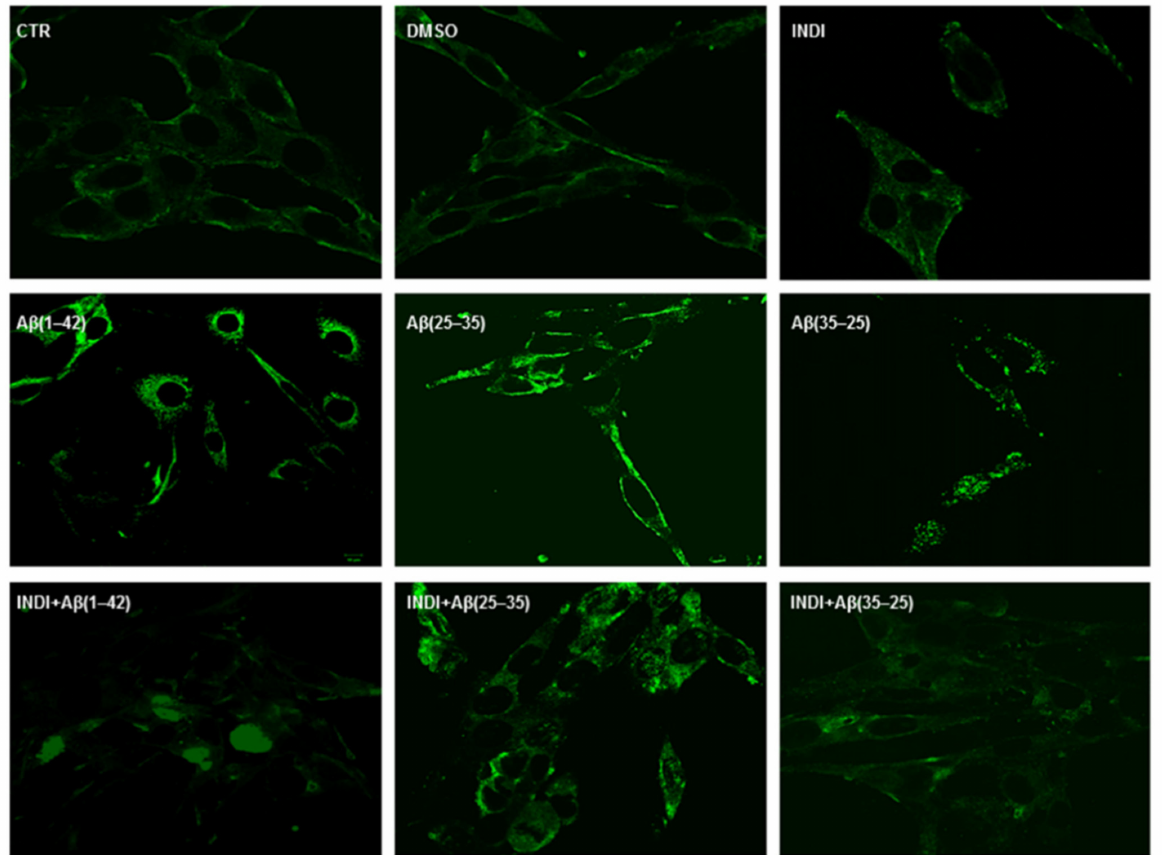
Figure 5. Confocal laser scanning microscopy of labeling immunocytochemistry for anti-TG2 in OECs. Images show different conditions: control, DMSO, 100 µ M indicaxanthin (INDI), 10 µ M A β (1-42) or A β (25-35) or A β (35-25) both in the absence and presence of 100 µ M INDI for 24 h. Scale bar 20 µ